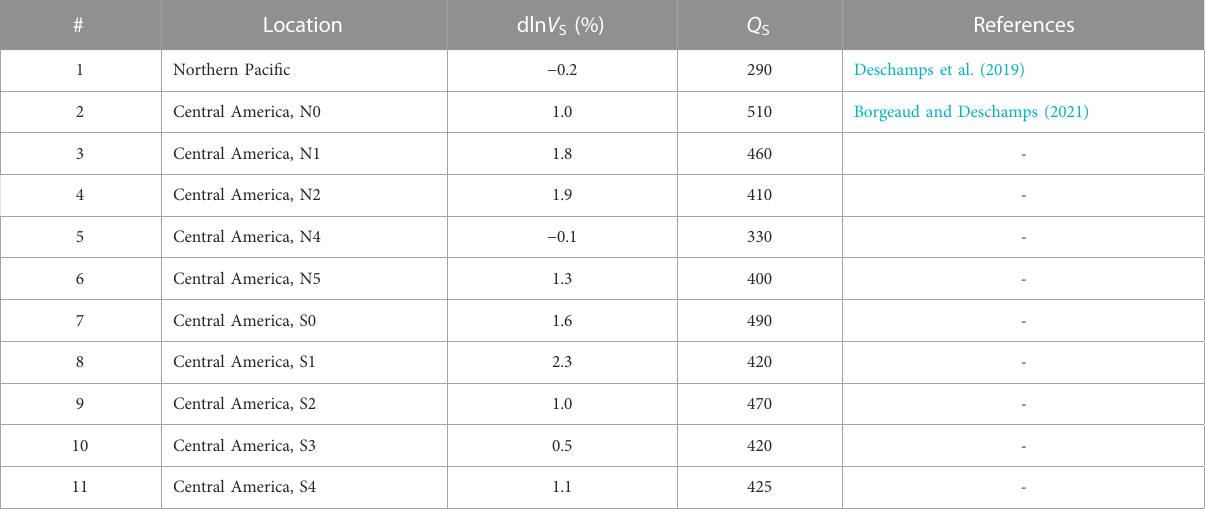
TABLE 1 Values of shear velocity anomalies (dln V S ) and attenuation ( Q S ) used to estimate the CMB temperature, T CMB . Values of dln V S are with respect to the PREM (Dziewonski and Anderson, 1981) value in the lowermost 50 km, V PREM = 7.26 km/s.